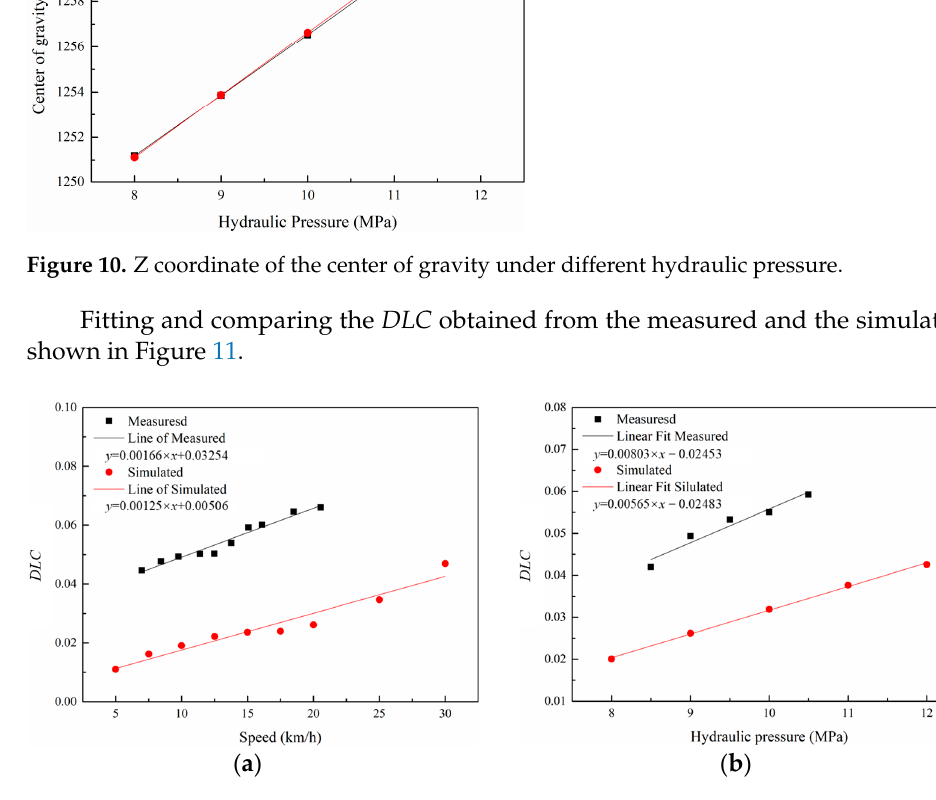
Figure 11. Comparison of DLC between measured and simulated. ( a ) Different Speeds. ( b ) Different